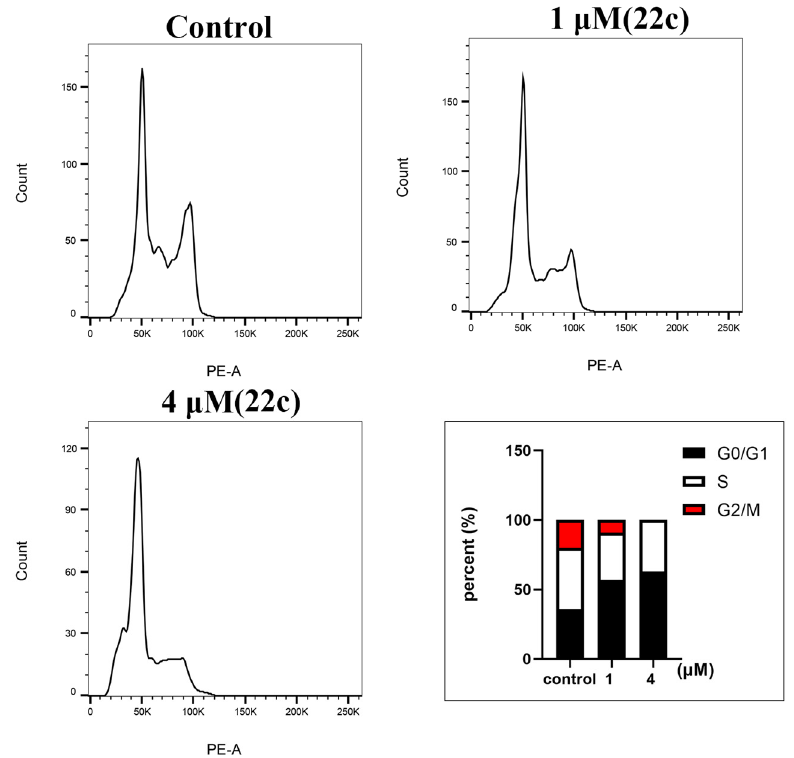
Figure 4. Flow cytometry analysis of apoptosis via Annexin V-FITC/PI staining after treatment with compound 22c at indicated concentrations for 24 h in HCT − 116 cells.